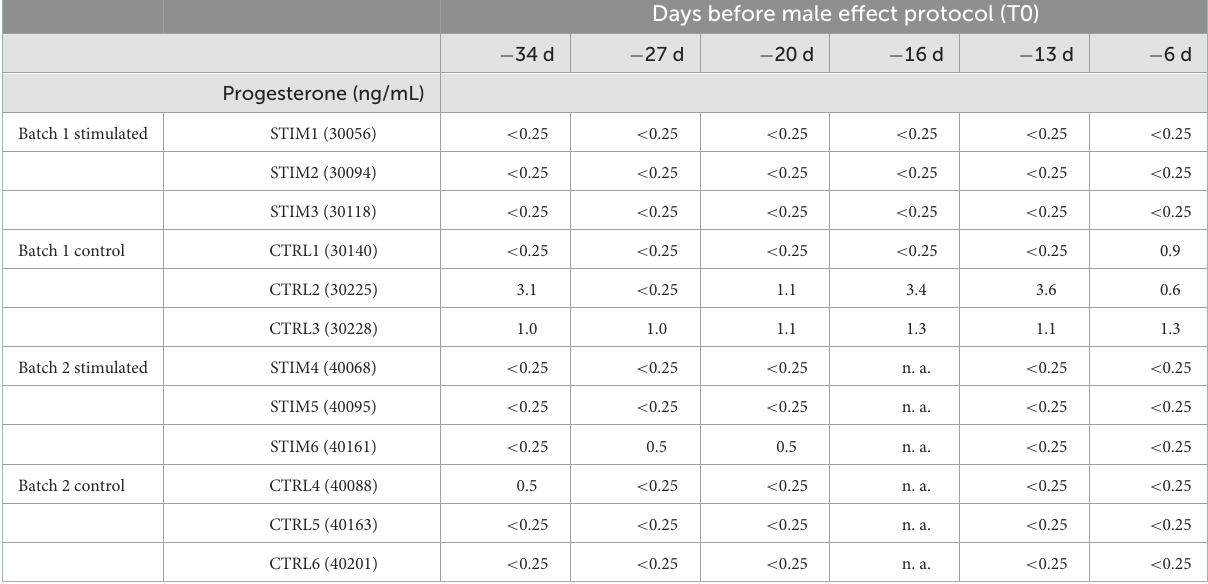
TABLE 1 Monitoring of progesterone concentration in ewe’s blood every week before exposure to the